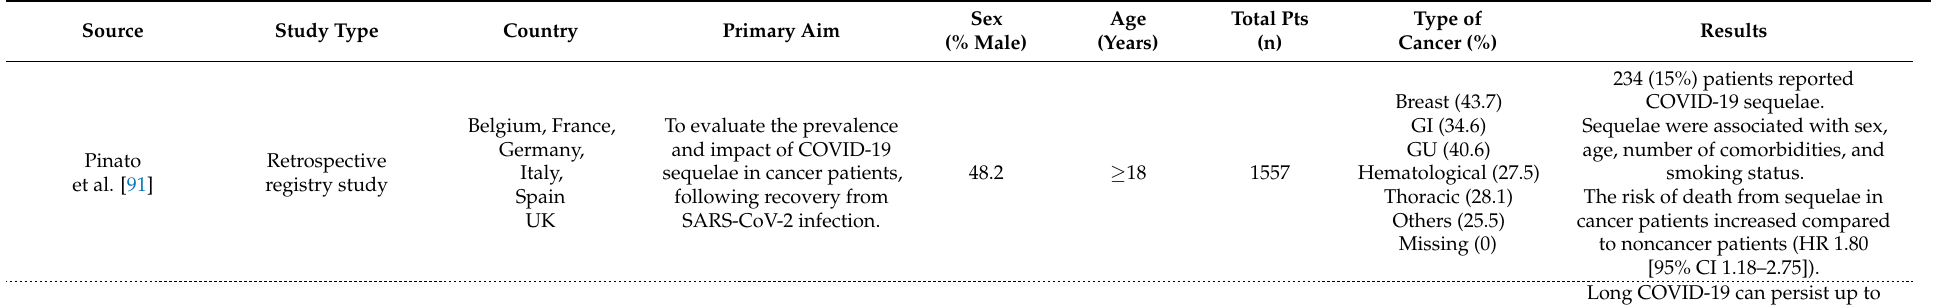
Table 4. Studies on Long COVID and